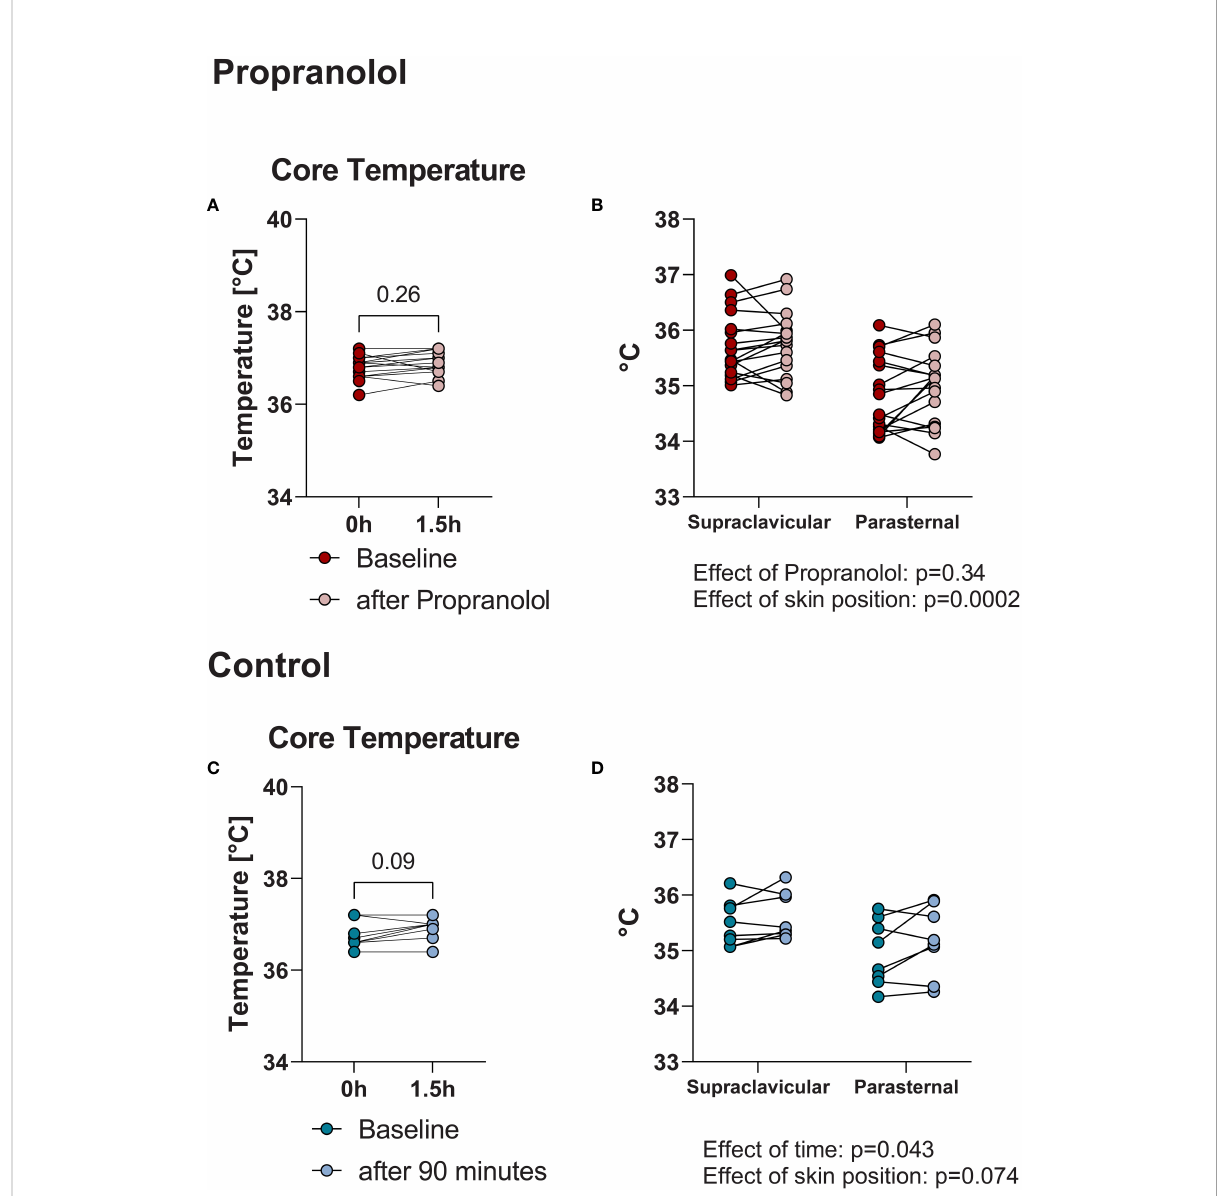
FIGURE 5 Mean tympanic temperature did not change after administration of propranolol: baseline 37.0 ± 0.25°C and 90 minutes after propranolol: 37.0 ± 0.27°C (p=0.26) (A) . Control visit (90-minute resting phase): baseline: 37.0 ± 0.29°C, after 90 minutes: 37.0 ± 0.24°C (p= 0.09) (C) . Mean supraclaviculare skin temperature compared to parasternal skin temperature as a reference. Supraclavicular skin temperature was higher than parasternal (effect of supraclavicular vs. parasternal position, p=0.0002) but did not signi fi cantly change after propranolol (effect of propranolol p=0.34) (B) . Similar results were observed during the control visit (D)